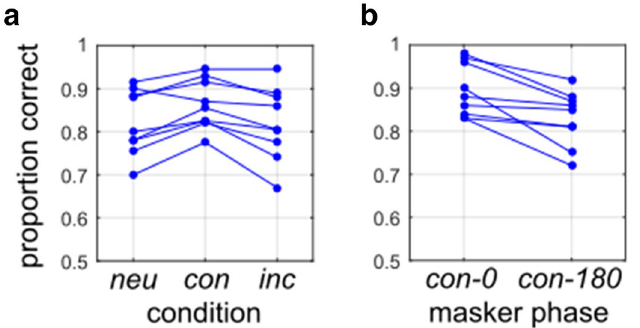
Figure 7. Effects of masking LSBs on LTB segmentation. ( a ) Performance for N = 9 observers in Experiment 4a, segmenting LTB stimuli using a proportion of unbalanced micro-patterns ( π U ), set at 75% JND for each observer, as measured in Experiment 1a. We see similar performance for most observers in the absence of a masker (neutral case, neu ) as well as with a masker having congruent ( con ) and incongruent ( inc ) orientation. Here the congruent case pools across in-phase and opposite-phase conditions. ( b ) Performance for same observers for congruent stimuli which are in-phase ( con-0 ) and opposite-phase ( con-180